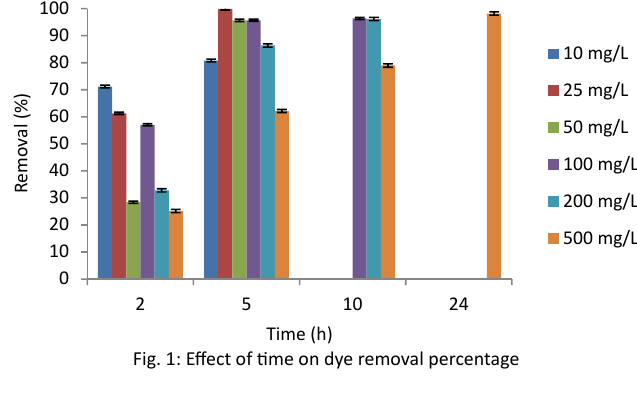
Fig. 1: Effect of time on dye removal percentage